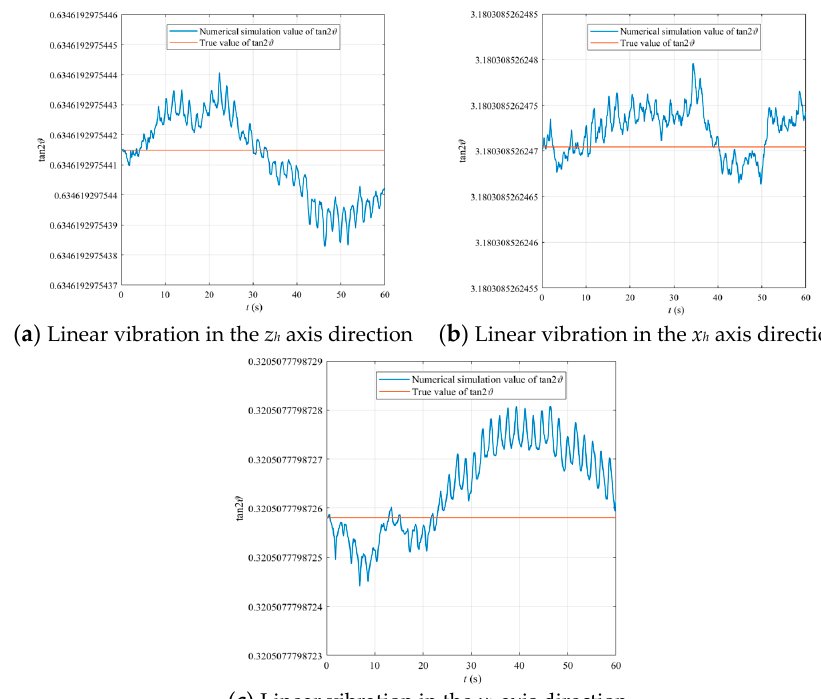
Figure 6. Standing wave binding of a hemispherical resonator containing the first–third harmonics of mass imperfection under linear vibration.